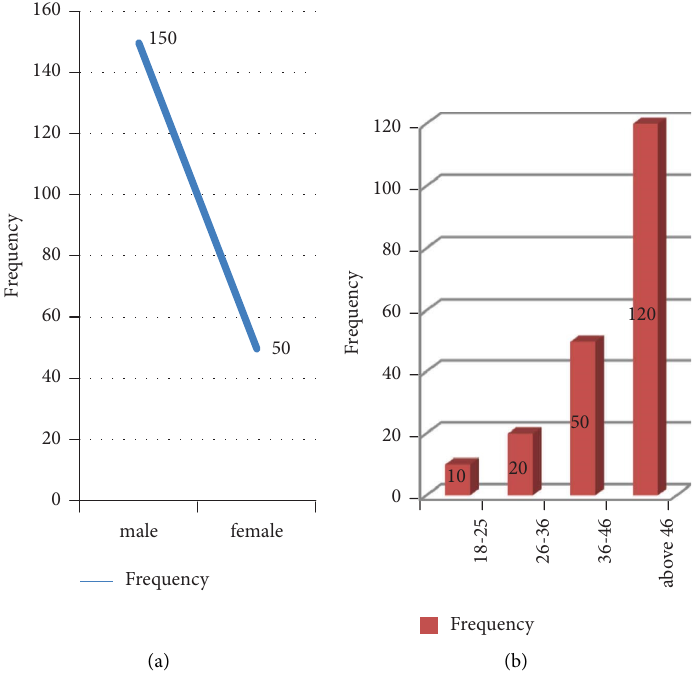
Figure 2: Te diagrams showing (a) sex and (b) age of